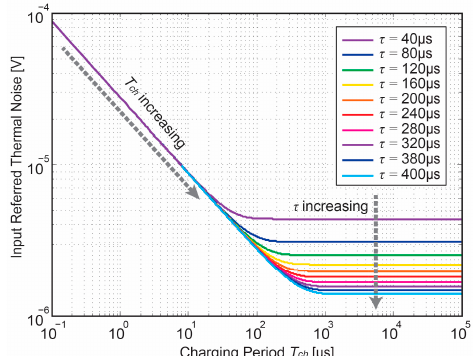
Figure 8. Input referred thermal noise as a function of charging period T ch .